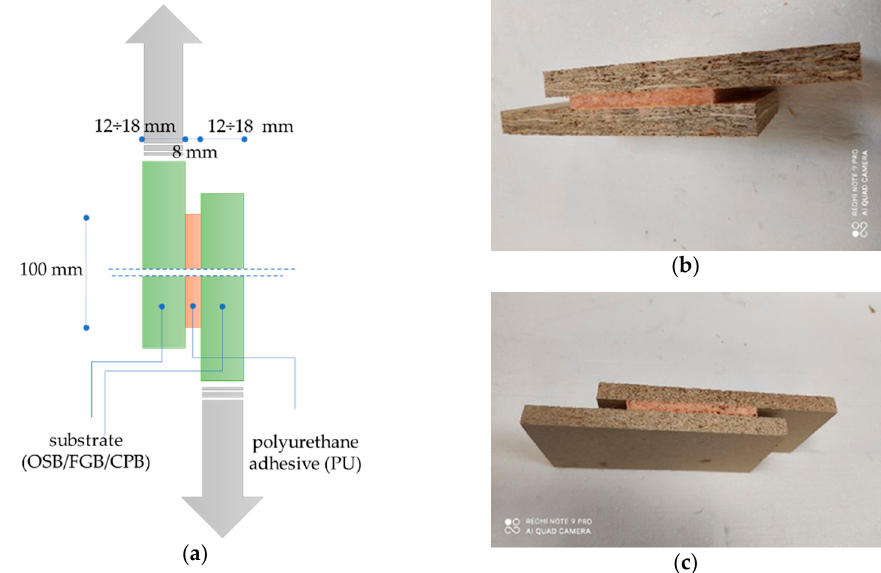
Figure 4. Samples for shear strength and shear modulus test: ( a ) sample scheme, ( b ) OSB/25/30 series sample and ( c ) CPB/25/30 series sample.